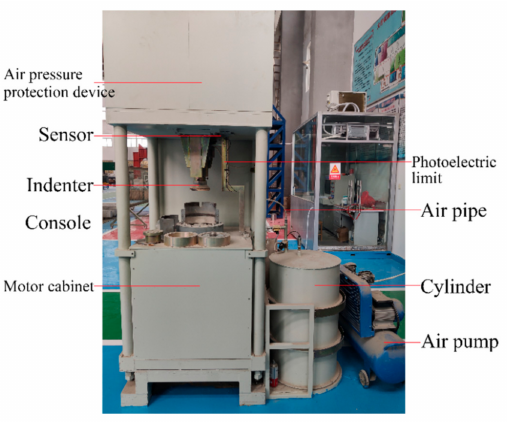
Figure 4. Road material vibration rotary compaction device.